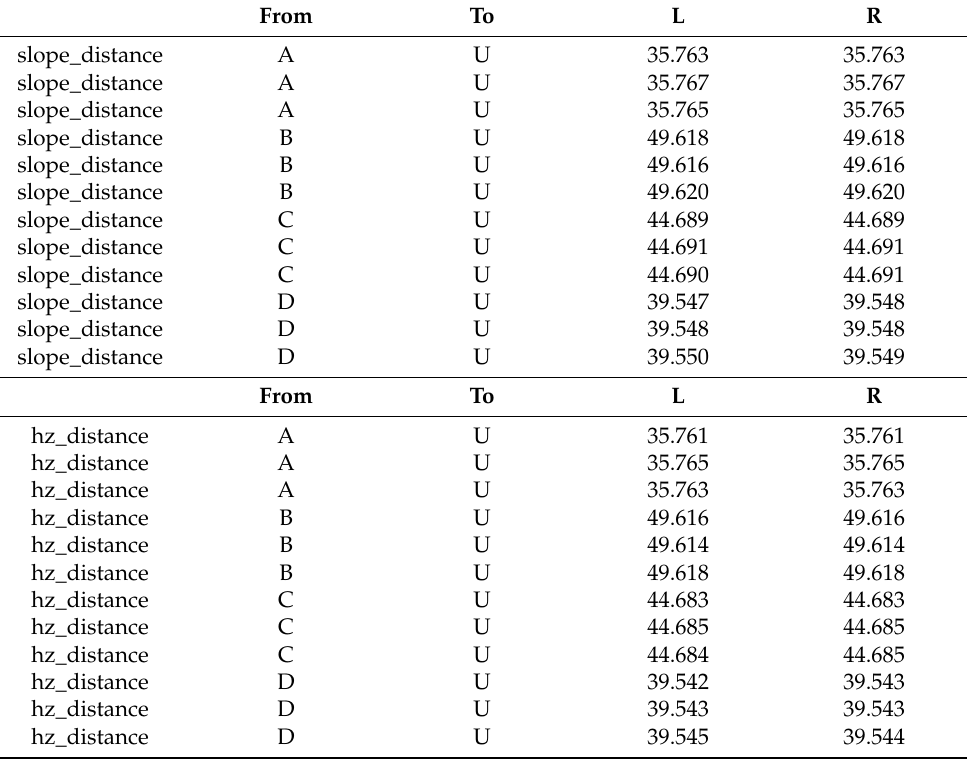
Table 4. Total-station slope distances and horizontal distances observed from the fieldwork.